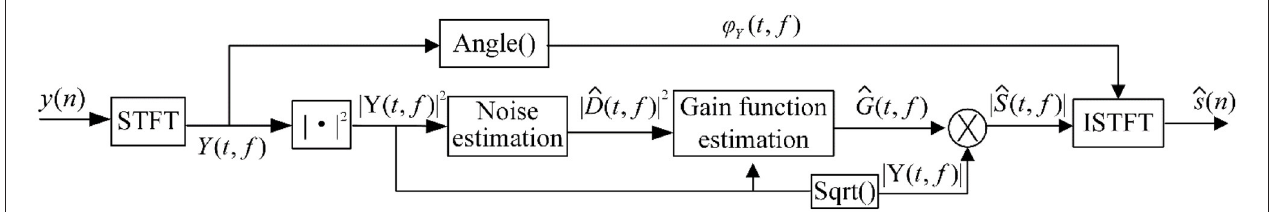
FIGURE 1 | The diagram for WF-based SE.